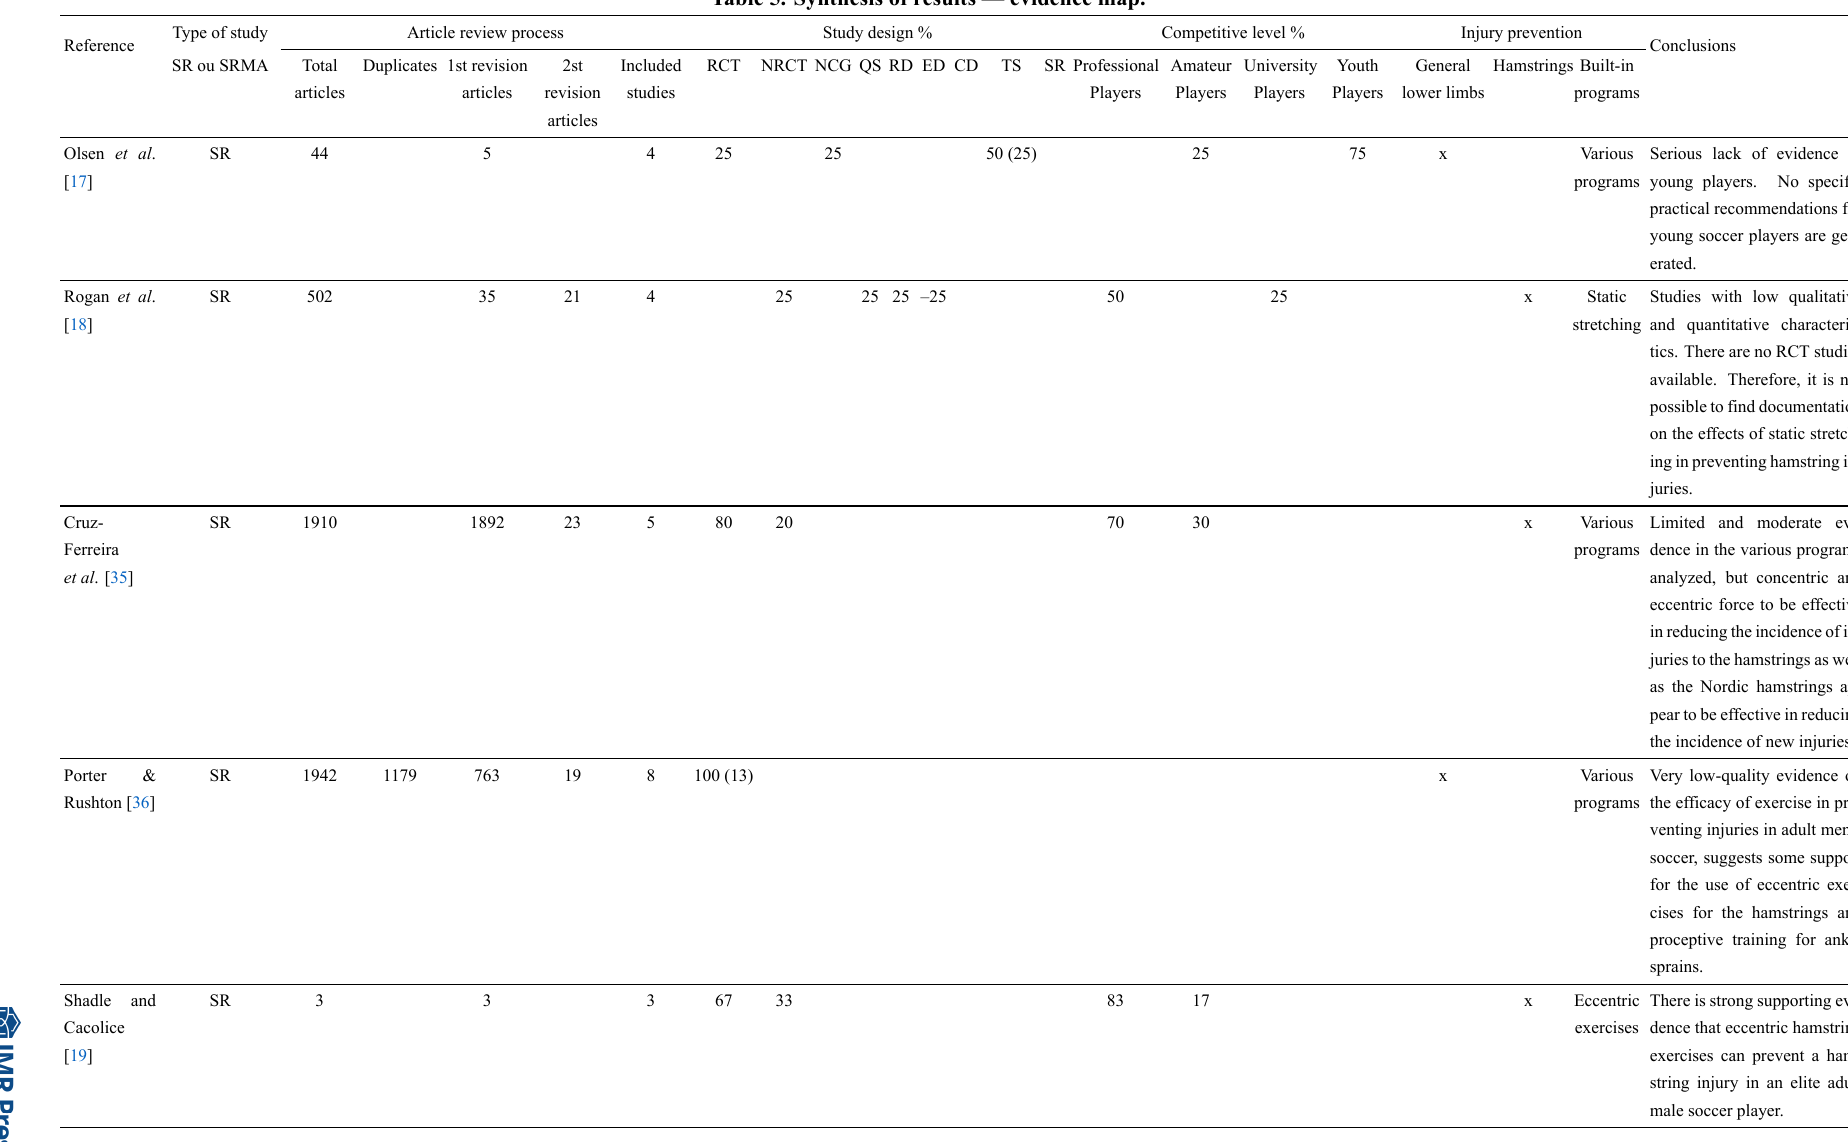
Table 5. Synthesis of results — evidence